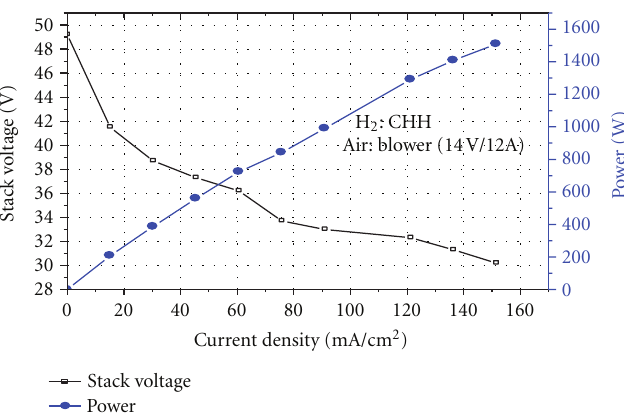
Figure 11: 1.5 kW fuel cell performance